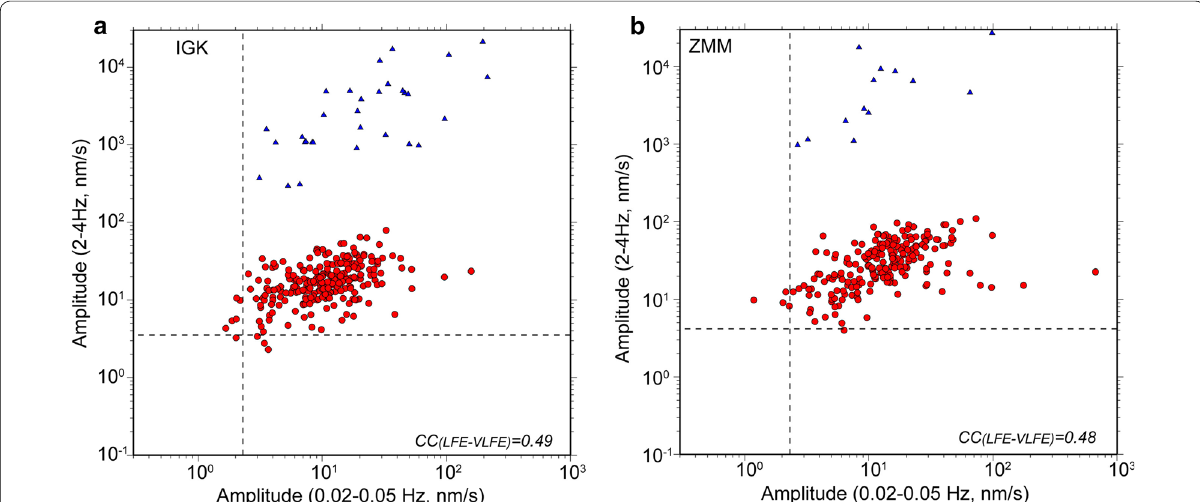
Fig. 11 Maximum amplitude of low-frequency earthquakes (LFEs) and very low frequency earthquakes (VLFEs). a Red circles show the maximum amplitude of LFEs as a function of association with VLFEs at IGK. Blue triangles denote the maximum amplitude of ordinary earthquakes within the frequency range 2.00–4.00 Hz as a function of the frequency range of 0.02–0.05 Hz. The hypocenters of the ordinary earthquakes are distributed within 23.3°–23.7°N, 123.3°–124.7°E at depths of <40 km (Fig. 1a). Horizontal and vertical lines denote the averaged noise level in the frequency ranges of 2.00–4.00 and 0.02–0.05 Hz at IGK, respectively. b Same as a but at ZMM